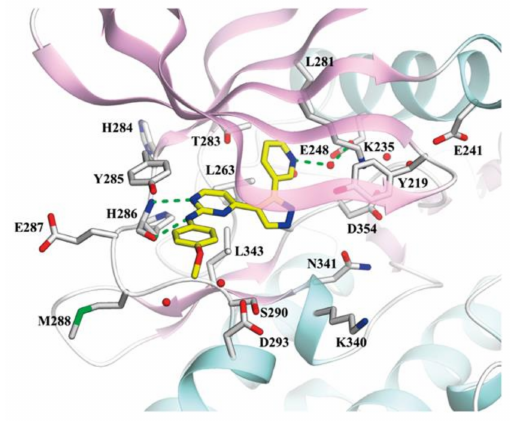
Figure 81. X-ray crystal structure of lead compound 75 in R206H mutant ALK2. White stick model: residues forming ATP binding pockets; Yellow stick model: lead compound; Green dashed lines: the hydrogen bonds between lead compound and active site; Red sphere: water molecules